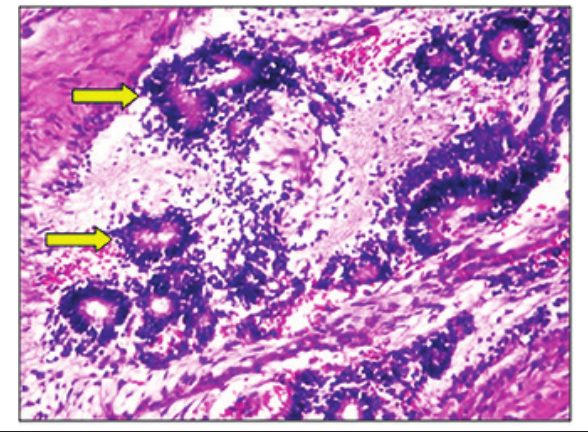
figuRE 5 − Photomicrograph (HE staining, 40× objective lens) Presence of mature epithelium (yellow arrows). HE: hematoxylin and